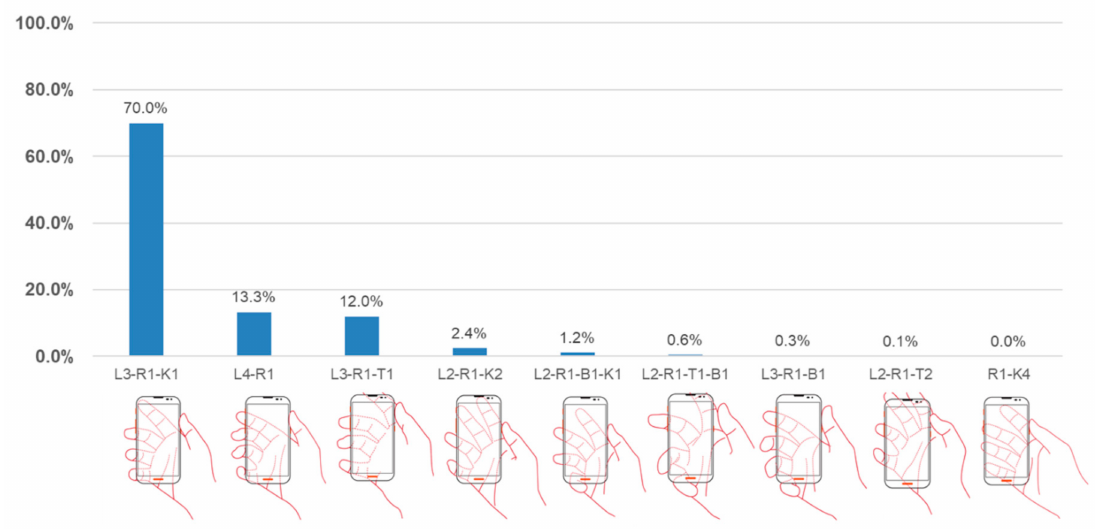
Figure 4. The use frequency distribution of grip posture for operation of the hard keys of a